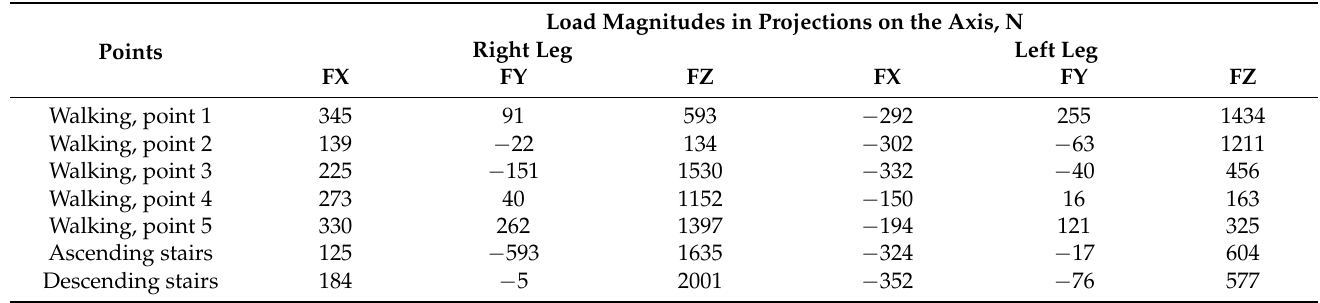
Figure 14. Resultant reaction forces in the hip joint during walking. Table 2. Calculated reaction forces in the hip joint, in three projections for both